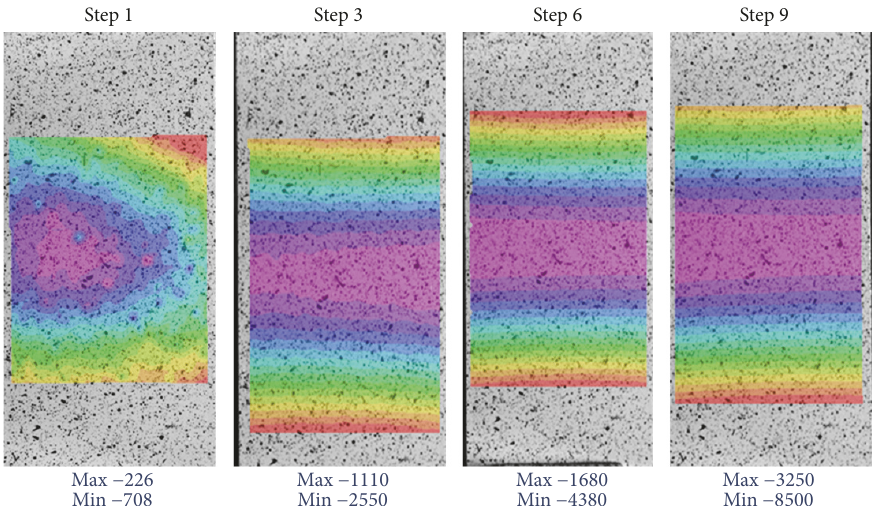
Figure 16: Out-of-plane displacement-principal step-central delamination specimen [ 𝜇𝜀 ].